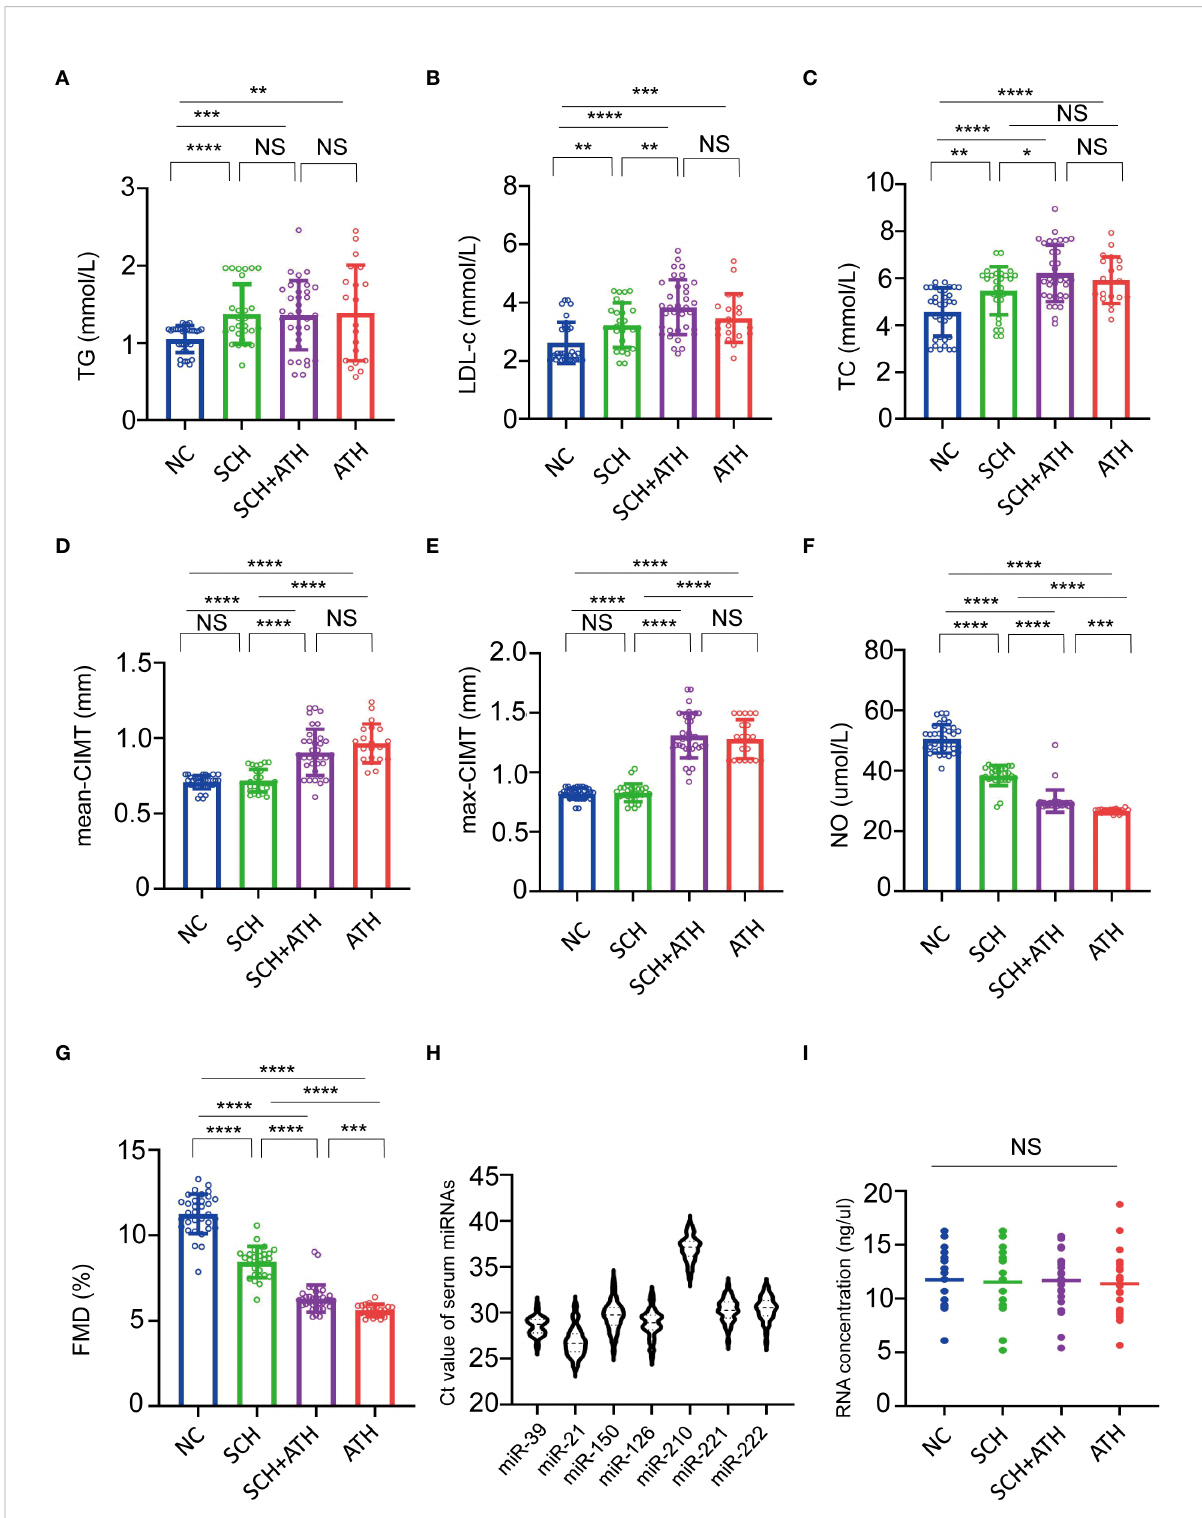
FIGURE 2 (A – G) . Multiple comparisons of baseline characteristics among NC, SCH, SCH+ATH and ATH subjects. *P< 0.05, **P< 0.01, ***P< 0.001, ****P< 0.0001, NS means no signi fi cance. (H) The six miRNAs and cel-miR-39 served as the spike-in control all showed reliable threshold cycle (Ct) values in all subjects. The horizontal lines indicate the mean. (I) The total RNA concentration among the four group were discovered no differences signi fi cantly. NS means no signi fi